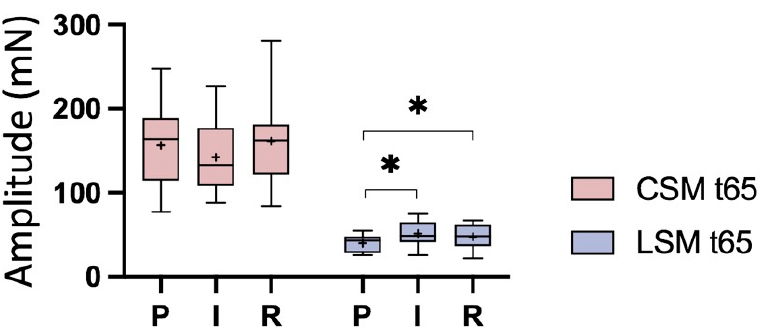
Figure 5. Box plot diagram of the nerve mediated contractile activity of the jejunal circular smooth muscle (CSM) and longitudinal smooth muscle (LSM) of 12 horses during pre-ischaemia (P), ischaemia (I), and reperfusion (R) at t65. Significant differences between the ischaemia phases (repeated measures ANOVA) are marked with an asterisk (* p < 0.05). The horizontal bar displays the median and the plus is the mean, the interquartile range is represented by the box and the minimum and maximum by the whisker